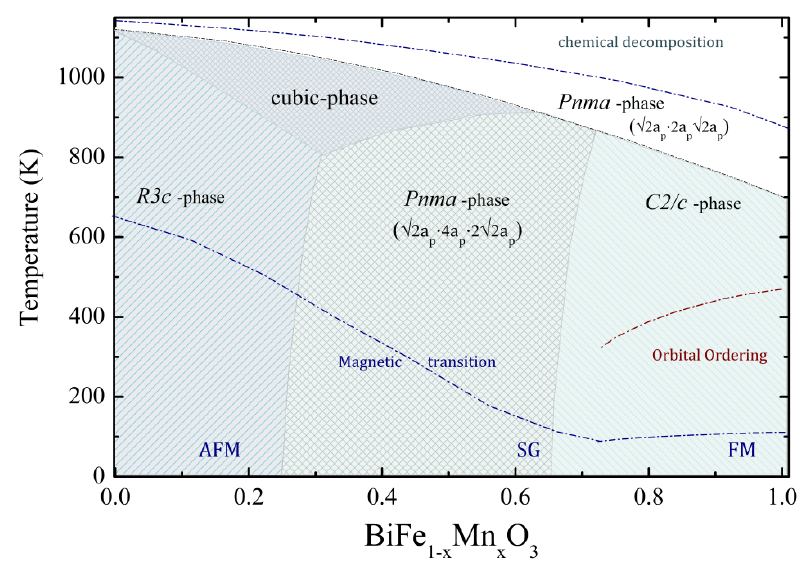
Figure 5. Preliminary structural and magnetic phase diagram of the solid solution BiMnO 3 -BiFeO 3 depending on temperature and chemical composition.